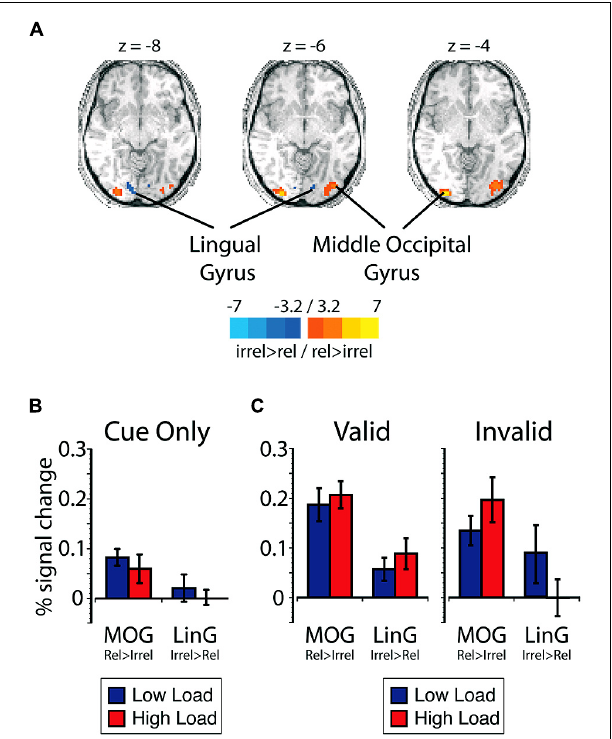
FIGURE 2 | (A) Data from the spatial localizer task showing regions with greater selectivity to relevant search locations compared to irrelevant flanker locations. Scale corresponds to the t -value.The left side of the brain is depicted on the left side of the figure.The peak percent signal change is plotted in blue for low load and red for high load (B) on cue-only trials within visual cortex ROIs plotted as a function of ROI, and (C) on cue + target trials within visual cortex ROIs plotted as a function of cue validity and ROI. Error bars plotted within this figure represents the standard error of the mean appropriate for within-subjects comparisons (Loftus and Masson,